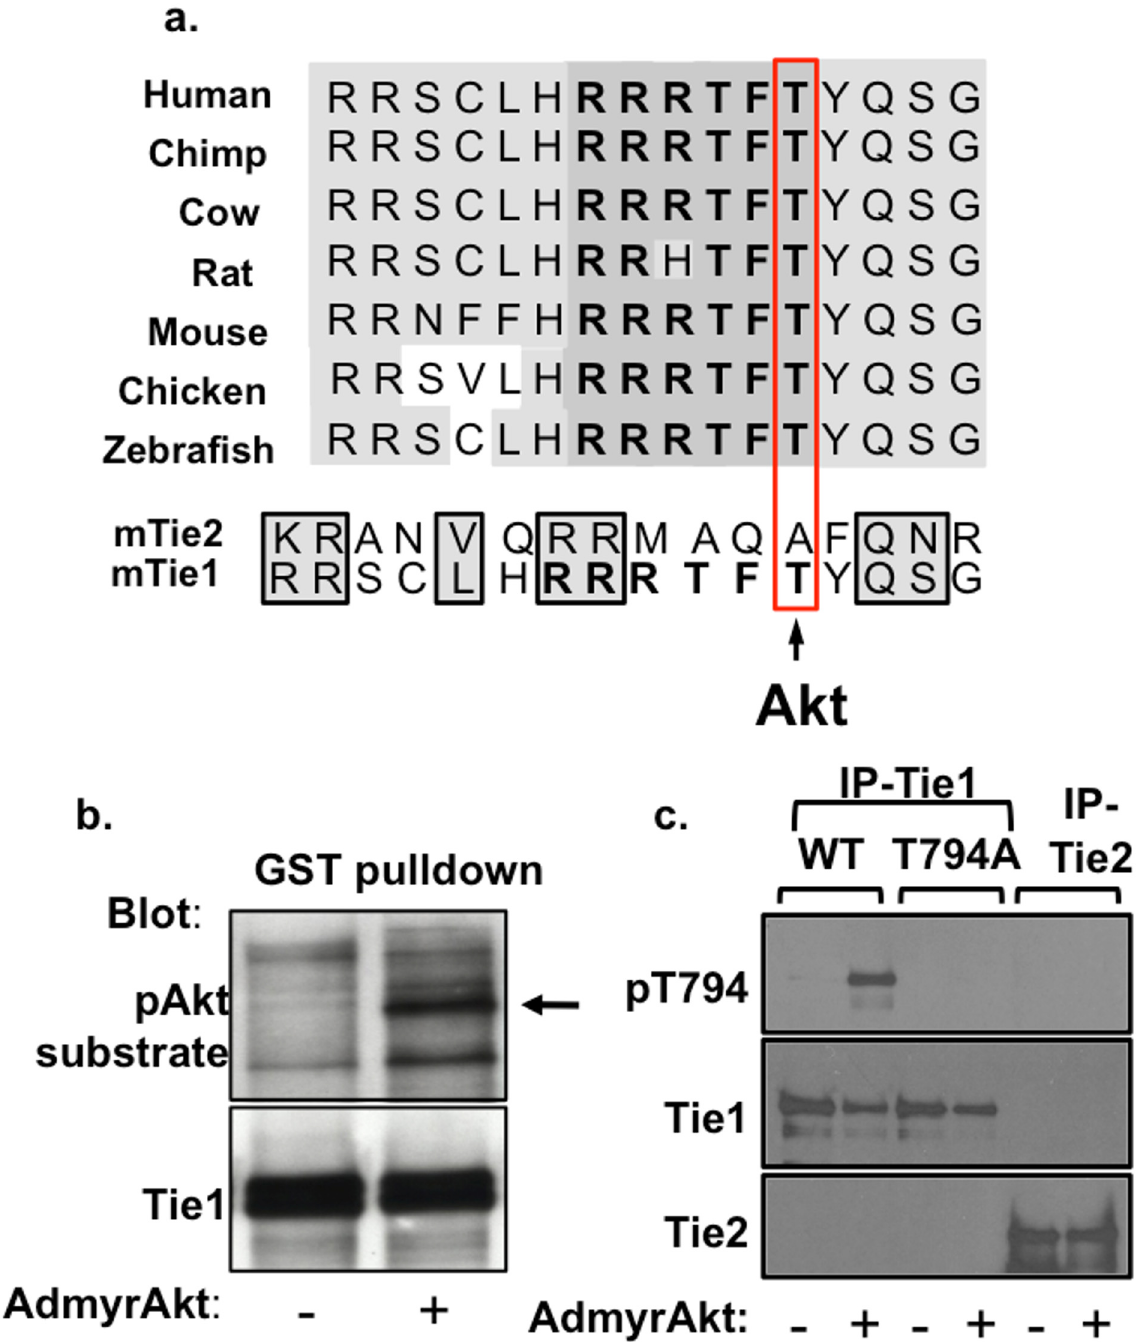
Fig 1. Tie1 contains an Akt consensus phosphorylation site and can be phosphorylated in vitro by Akt. a The juxtamembrane (JM) domain of Tie1 is highly conserved from zebrafish through humans (light gray), including a high probability Akt phosphorylation consensus sequence (RRRTFTY) within the JM region (dark gray). The predicted phosphorylation site at Tie1-Thr794 is not present in Tie2. b GST-Tie1 fusion protein was incubated with EC lysates that had been infected with AdEmpty (-) or AdmyrAkt (+) virus in an in vitro kinase reaction. Phosphorylated Tie1 (arrow) was detected with a phospho-Akt substrate antibody. c HUVECs expressing Tie1WT, -T794A, or Tie2 were infected with AdEmpty (-) or AdmyrAkt (+) and Tie1 or Tie2 was immunoprecipitated (IP) and probed with a phospho-specific Tie1-pT794